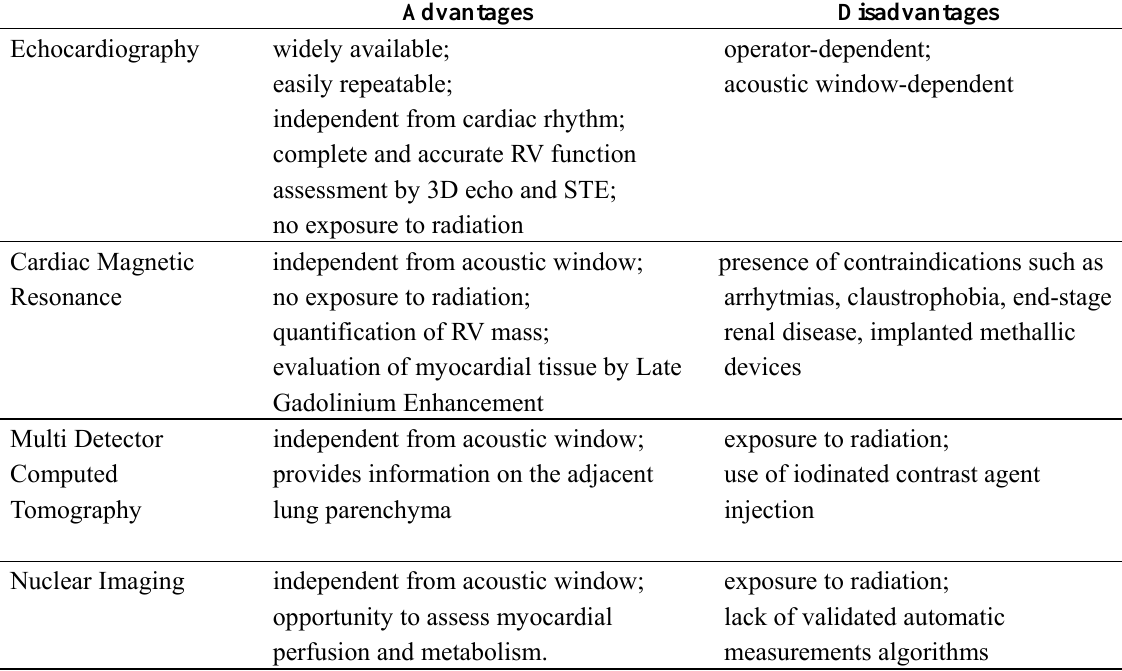
Table 2. Advantages and disadvantages of the different imaging modalities in right ventricle (RV) evaluation in the pulmonary hypertension (PH)